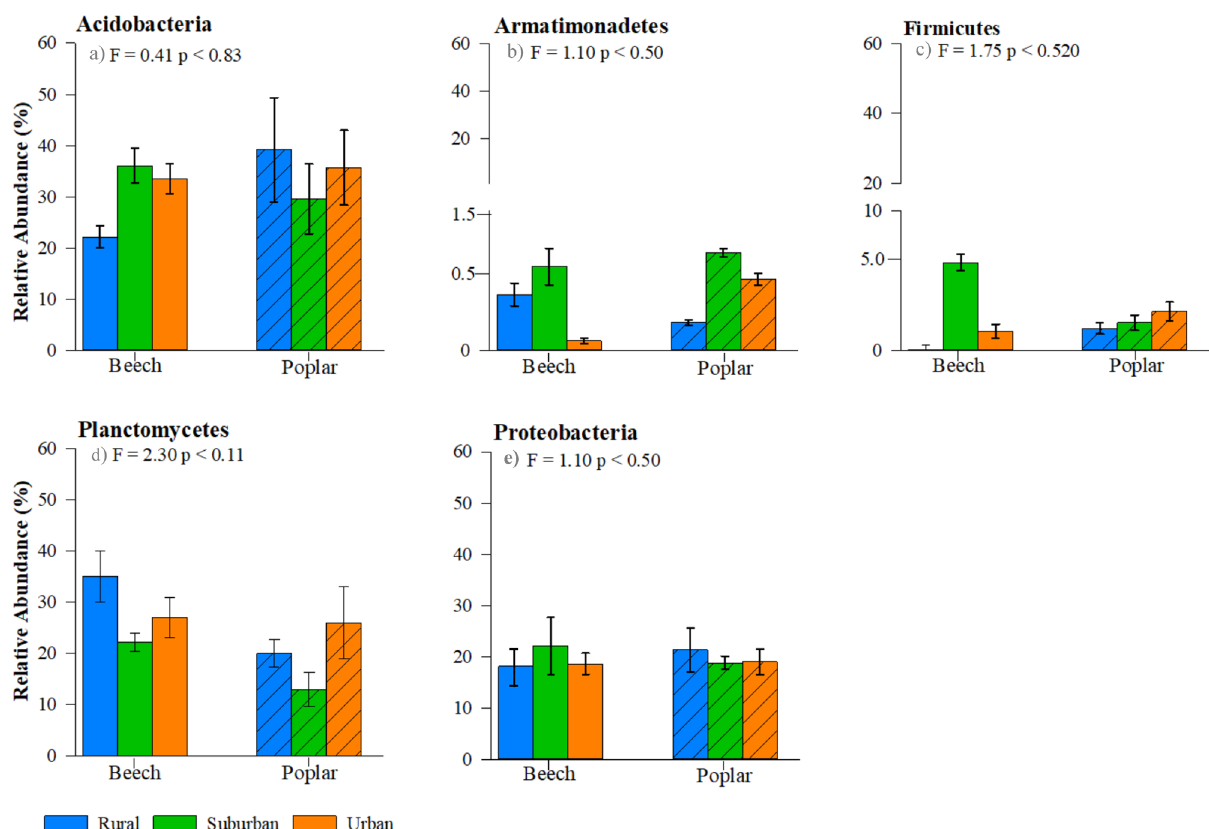
Figure 3. Relative abundance (%) of the dominant 16S rRNA gene sequences isolated from microbial community members at the phylum level (mean ± standard error) significantly influencing observed differences in NMDS plots within forest interiors. Samples are separated by forest type: urban (orange) suburban (green) and rural (blue) and tree (column